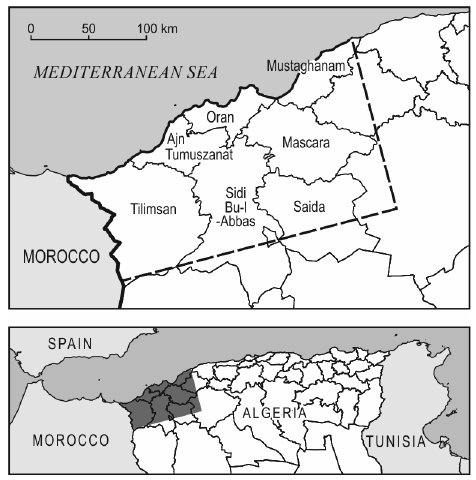
Fig. 1. Localisation of the study